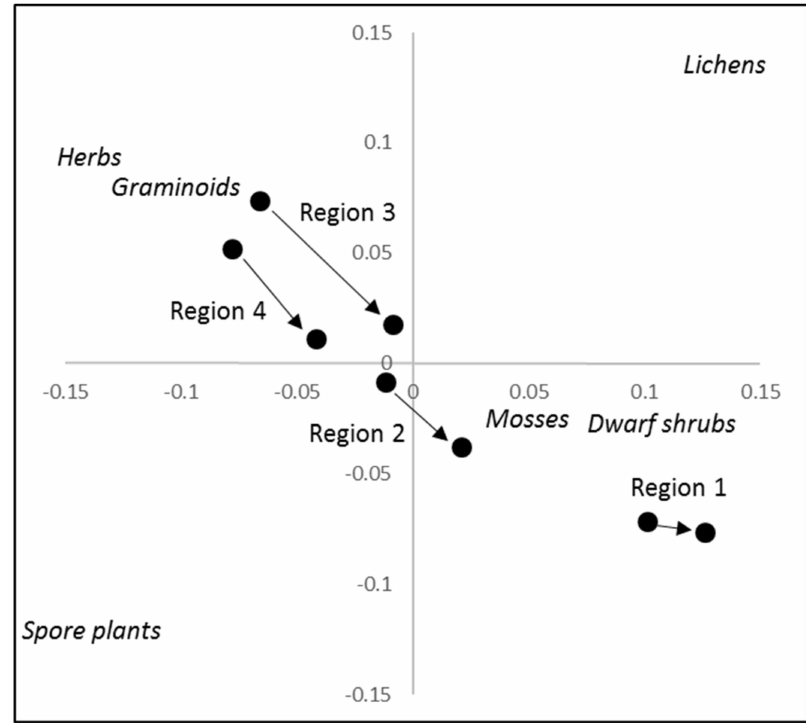
Figure 2. NMDS ordination (dimensions 1 and 2) of six species groups, where filled circles denote average “site scores” for the four regions at the two inventories. Arrows denote the direction of change. Note that, to increase the readability of the figure, the positions of the species group scores do not represent their actual scores along the axes, since these are outside the current axis’s ranges. However, their relative position indicates where they occur in the